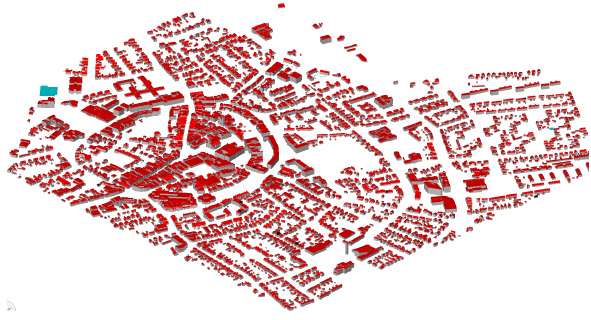
Figure 3. The 3D city model of the study area: a subset of Rijssen-Holten in the Netherlands.